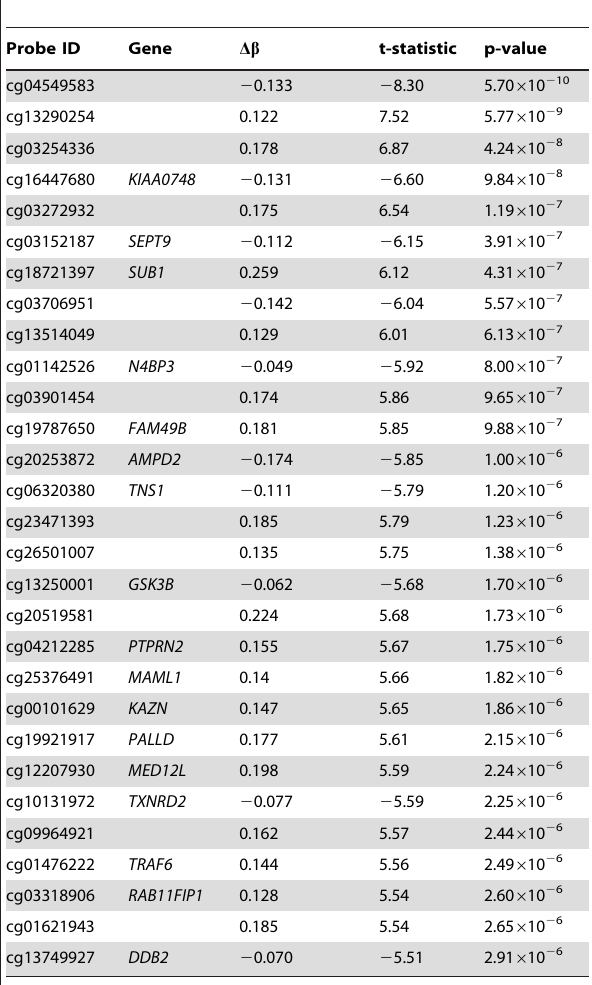
Db represents the average methylation difference between early PTB and term birth after adjustment for covariates.